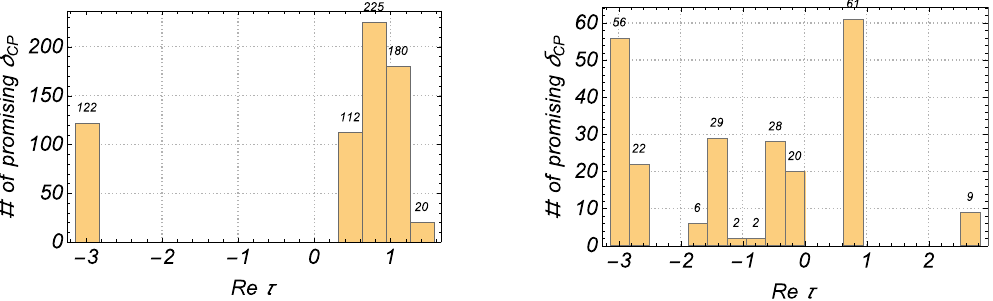
Figure 21 . Left panel: frequency of Re τ satisfying an inequality in eq. (4.8) for Im τ = 1 . 8 in Pattern VII. Digits on the top of histogram bins denote the numbers of combinations of Higgs VEVs. Right panel: the same one for Im τ = 2 .